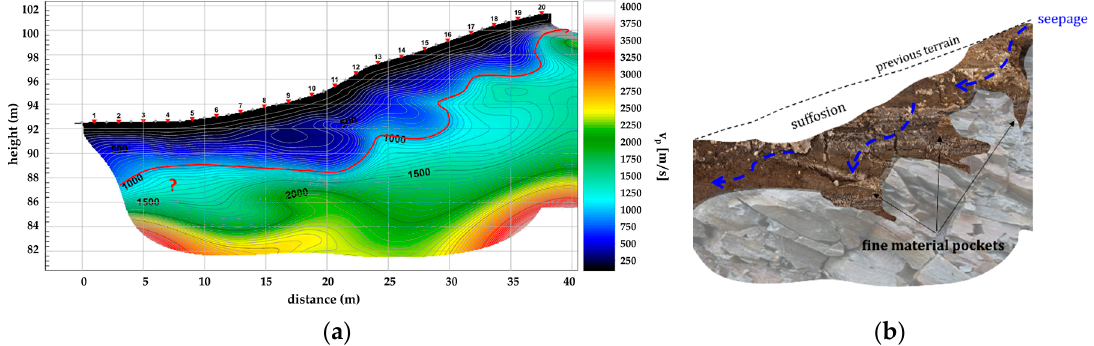
Figure 5. A suffosion on Rijeka-Zagreb highway: ( a ) seismic refraction profile perpendicular to the highway and ( b ) a suffosion scheme.